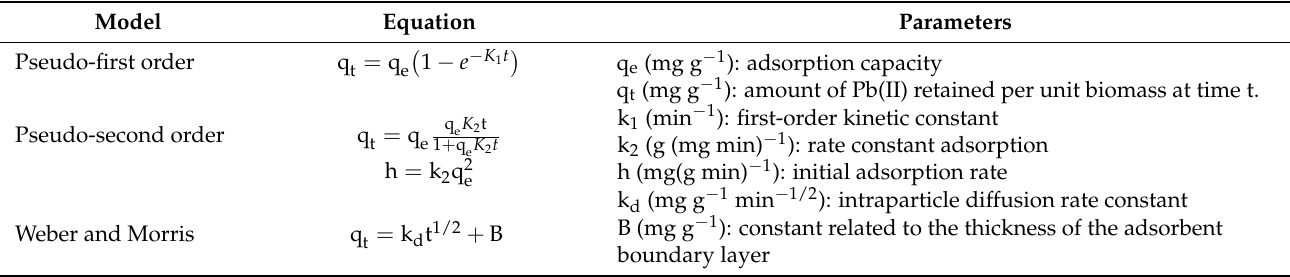
Table 7. Kinetic adsorption